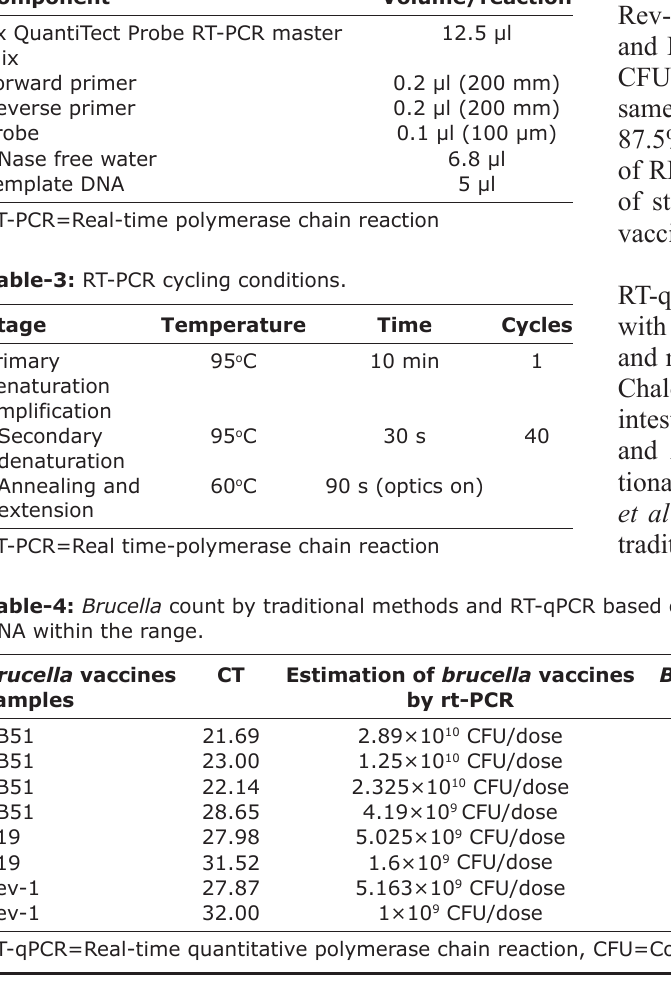
Table-2: Preparation of PCR master mix. Component